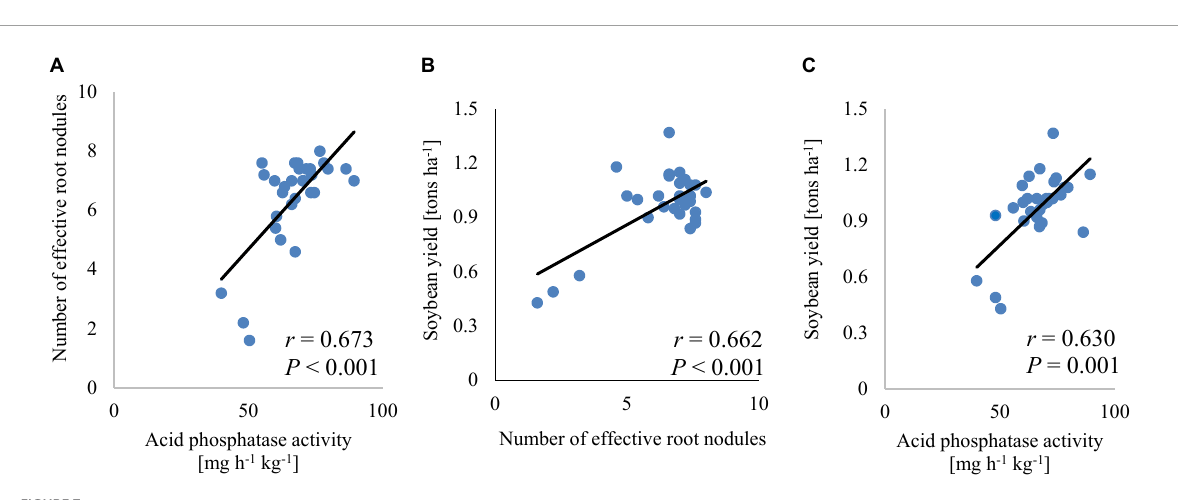
FIGURE7 Correlation of the number of effective root nodules and acid phosphatase activity (A) , soybean yield and number of effective root nodules (B) , or acid phosphatase activity (C) .